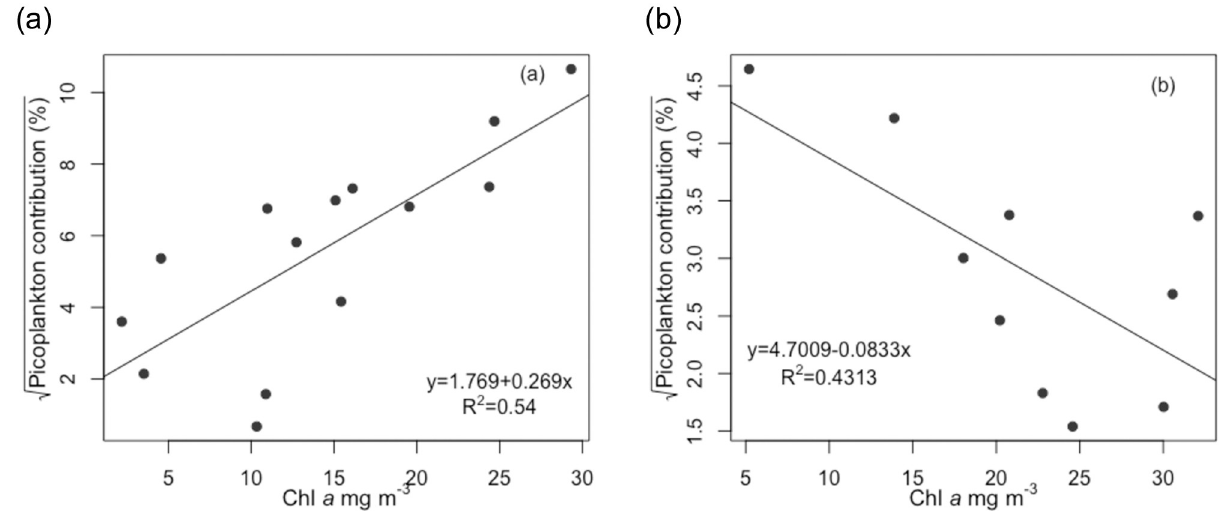
Fig 3. Relationship between total Chl a concentration and the proportion of phototrophic picoplankton Chl a in 2018 (a) and 2014 (b). Regression line is fitted to data.